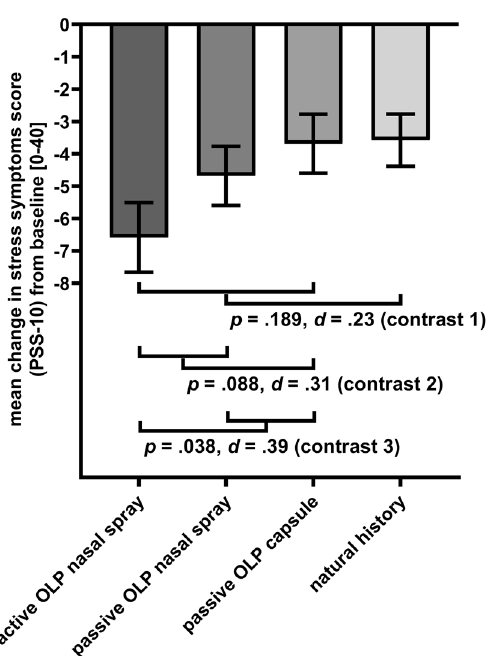
Figure 5. Planned contrasts for change in stress symptoms ( M , SE ; PSS-10) from pre- to post-intervention for all groups (contrast 1: all OLPs vs. natural history; contrast 2: OLP nasal spray (passive + active) vs. capsule; contrast 3: active OLP vs. passive OLP (nasal spray,